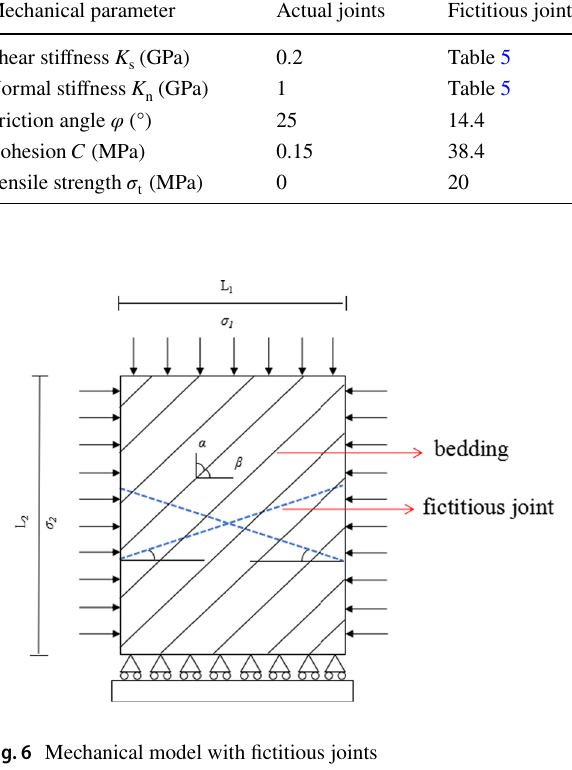
Fig. 6 Mechanical model with fictitious